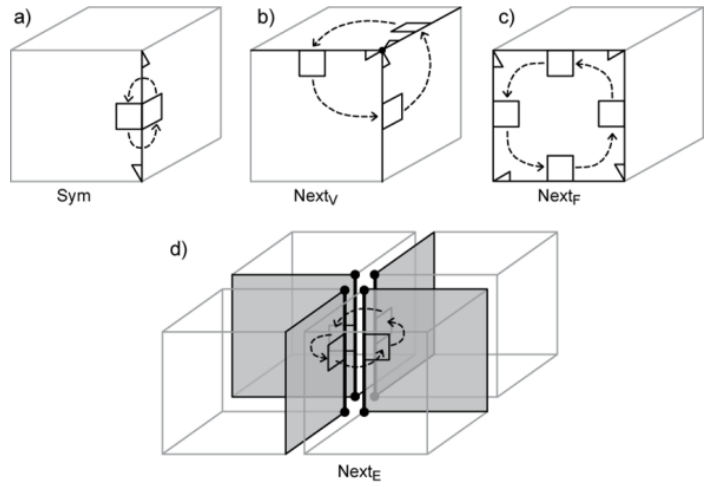
Figure 8. Navigational operators: (a) Sym ; (b) Next V ; (c) Next F ; (d) Next E (compound operator).